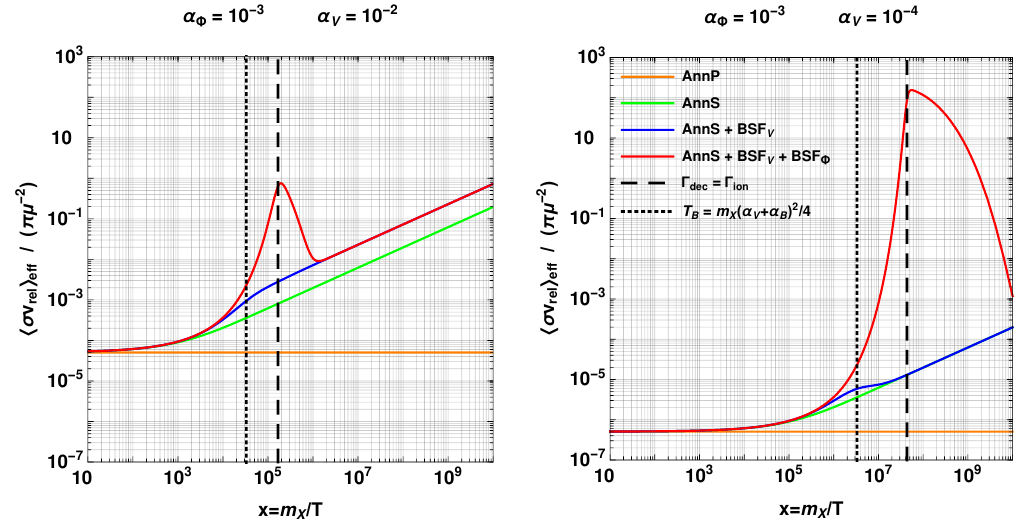
Figure 13 . The thermally-averaged velocity-weighted e(cid:11)ective cross-section as a function x = m =T , for (cid:12)xed (cid:11) = 10 (cid:0) 3 and two di(cid:11)erent values of (cid:11) X (cid:8)